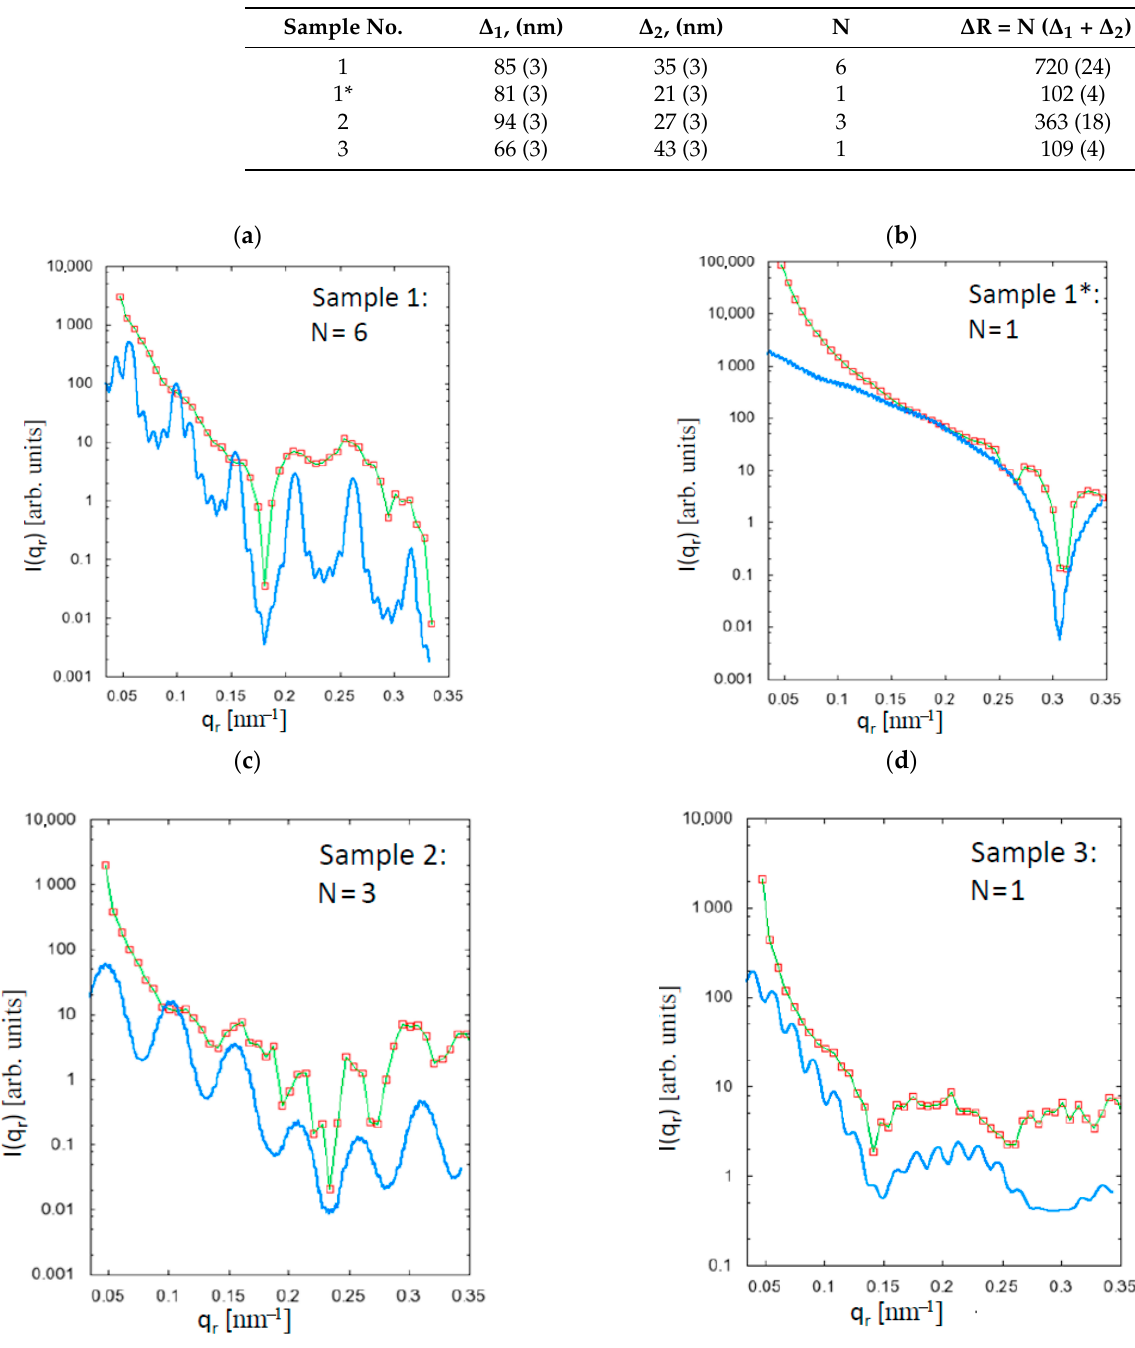
Figure 5. Analysis of the equatorial scattering contributions (red squares and green curves) using the model function (blue curves, see [11]) for sample 1 ( a ), sample 1* ( b ), sample 2 ( c ) and sample 3 ( d ). The parameters ∆ 1 and ∆ 2 were manually found by variation of the respective values derived from the equatorial Patterson function within their uncertainties, the values ∆ ρ 1 and ∆ ρ 2 are constants as given in [11]. The results show that strong drawing leads to a shrinking of the region ∆ R = N( ∆ ∆ 1 + 2 ) where the densities decay (see Table